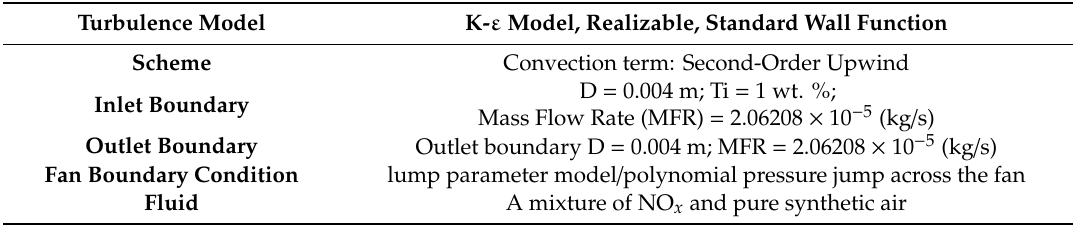
Table 4. Summary of the simulation assumptions and boundary